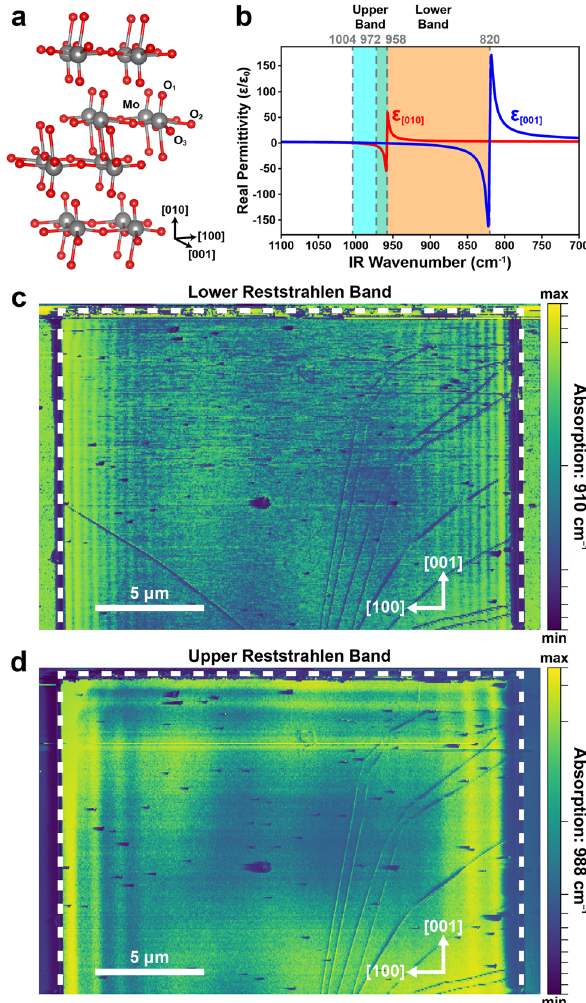
Figure 1: Photothermal induced resonance (PTIR) detects hyperbolic phonon polaritons (HPhPs) in a MoO 3 single crystal. (a) Crystal structure of orthorhombic α -MoO 3 (space group D 16 depicting Mo (in gray) at the center of octahedra composed of three crystallographically inequivalent oxygen atoms (labeled “ O 1 , ” “ O 2 , ” and “ O ” )inred.(b)Realcomponentsofthecomplexelectricpermittivitytensor 3 ( ε ), relative to that of free space ( ε 0 ), along the [001] (blue line) and [010] (red line) crystallographic directions in MoO 3 . The spectral regions highlighted with pale red and blue backgrounds represent the two, partially overlapping, reststrahlen bands probed in this work. Real-space PTIR absorption maps at (c) 910 cm − 1 and at (d) 988 cm − 1 of a MoO 3 fl ake ( ≈ 315 nm thick) deposited on a uniform, gold-coated glass substrate. Dashed lines depict the approximate locations of the fl ake edges. Polaritons in MoO 3 manifest as a superposition of periodic fringes of varying absorption intensity. The [100] and [001]